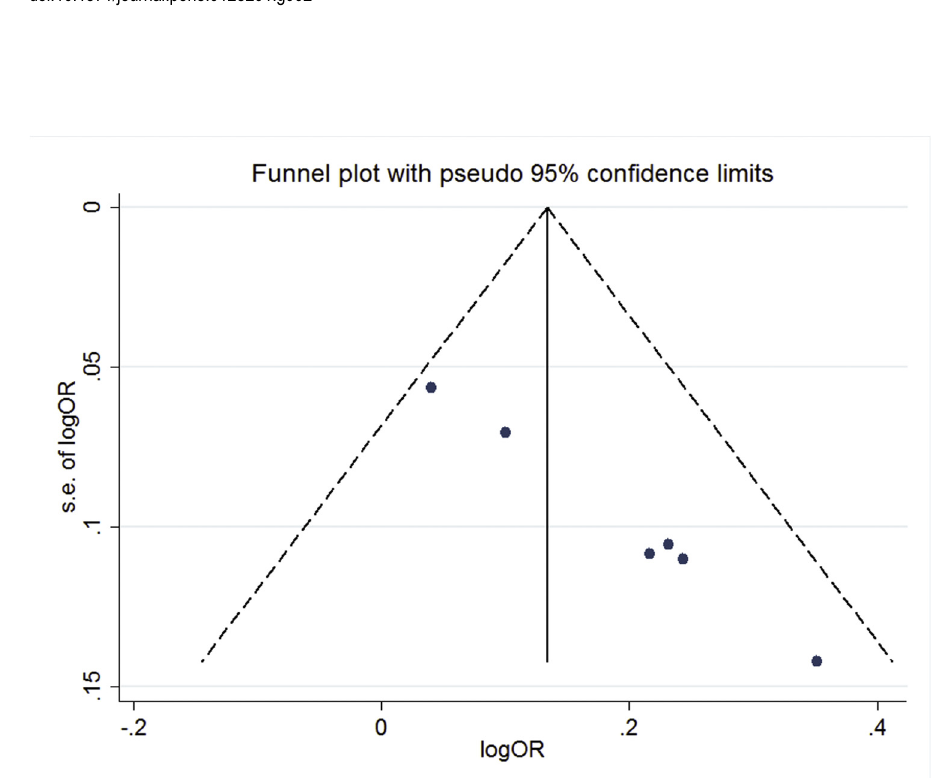
Fig 3. The overall funnel plot under dominant